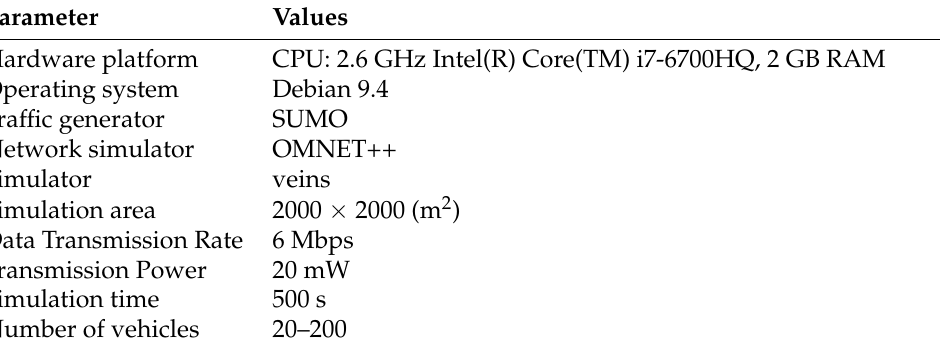
Table 2. Simulation